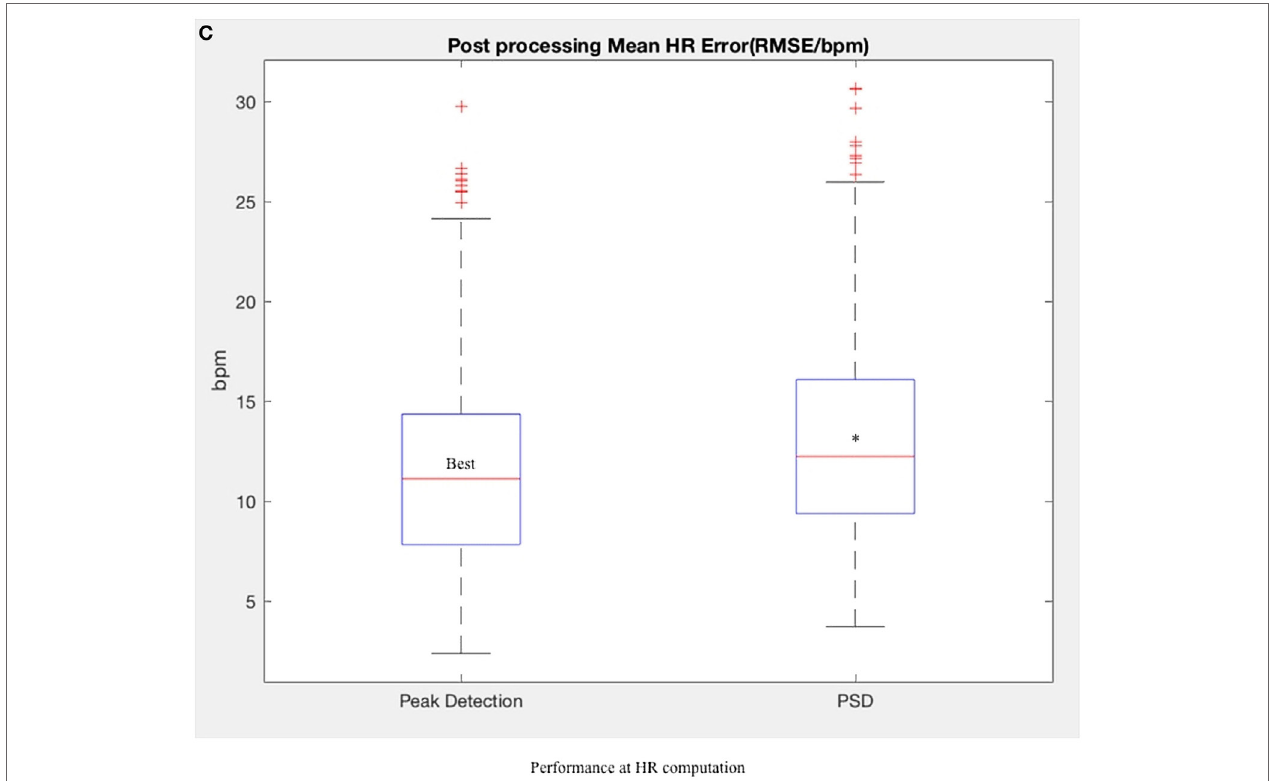
FigURe 7 | Method performance at each stage. “best” indicate the best methods according to average performance. Other methods are tested against the best method (ns, non-significant; *, p < 0.05; **, p < 0.01). (a) Face segmentation performance. (b) Performance at face blood volume pulse (BVP) extraction. (c) Performance at heart rate (HR)